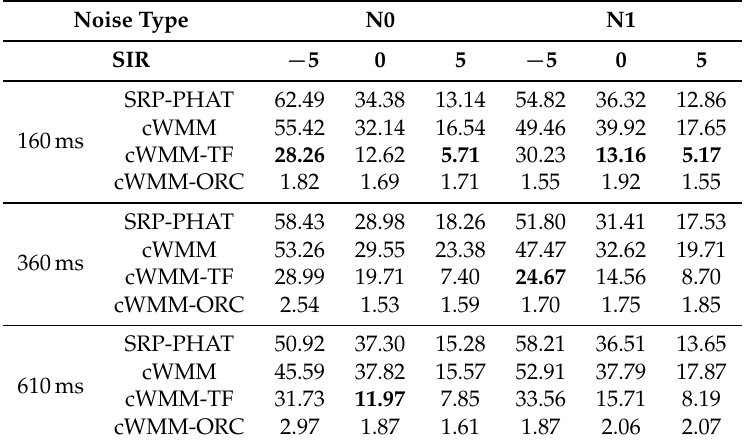
Table 2. The MAE ( ◦ ) of the algorithms in different test environments with competing speakers. The bold numbers indicate the best results excluding cWMM-ORC for each SIR.